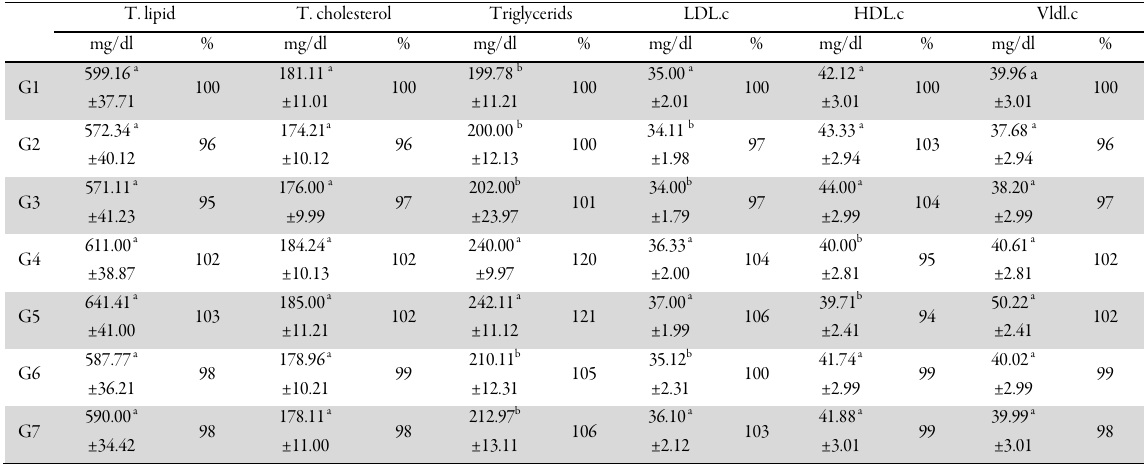
Table 4. Values of lipid profile of normal young groups treated by wheat and color T.